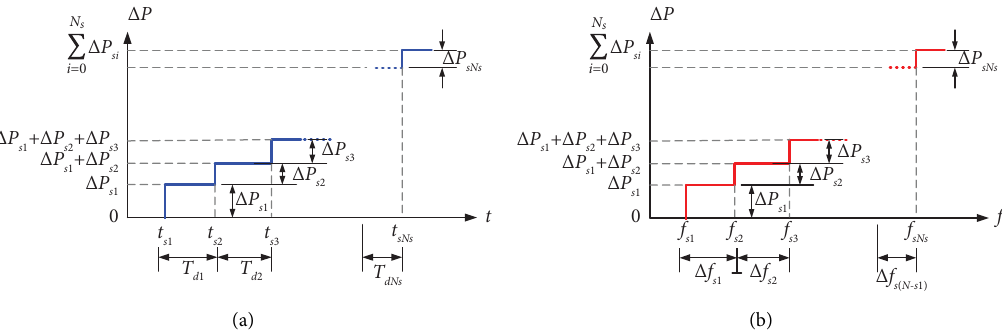
Figure 1: UF-relay parameters: (a) power-time characteristic and (b) power-frequency (P-f)